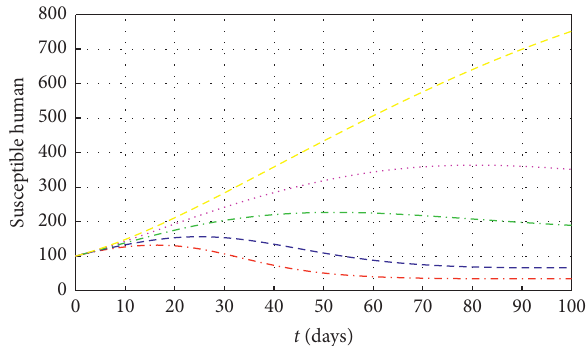
Figure 5: Population of aware infected humans with and without awareness (without awareness (red line); with low to high awareness rate awareness (blue, green, magenta, and yellow